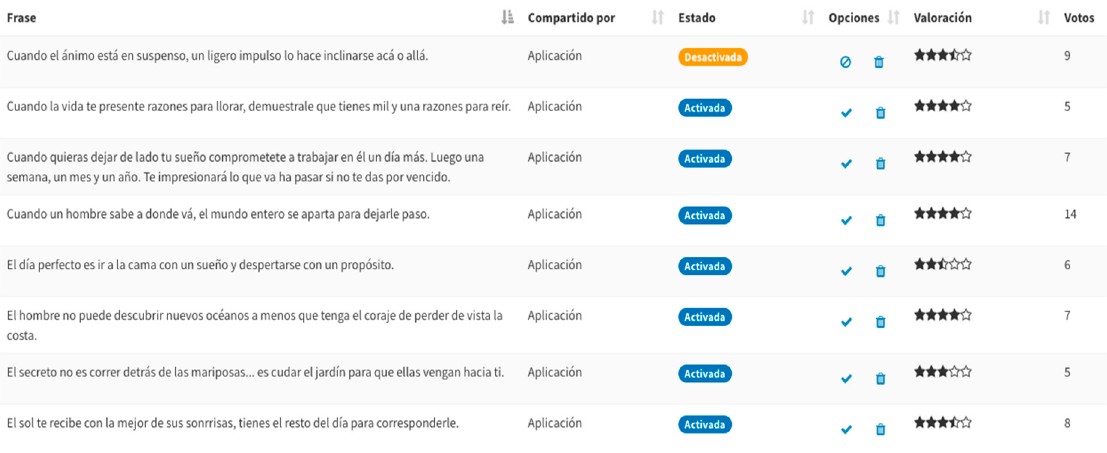
Figure 7. Screens of the web interface where the psychologists can see and manage the phrases.